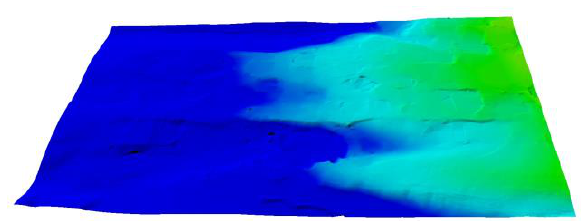
Figure 3. Overview of the generated DTM